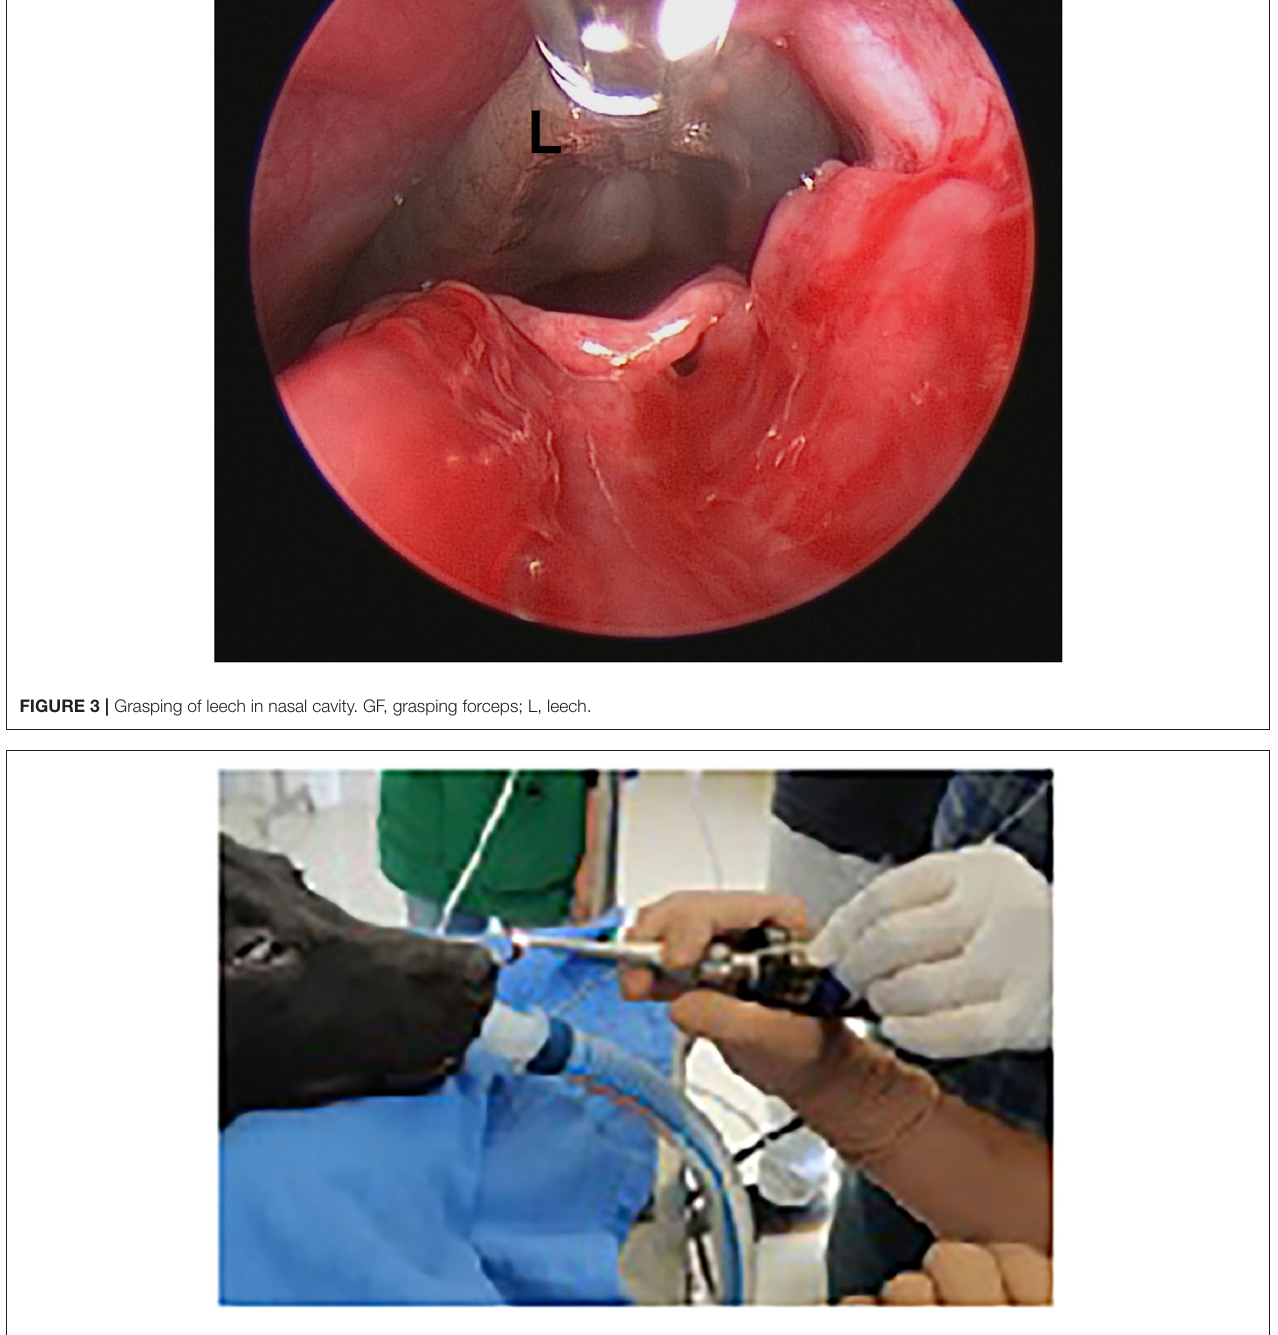
Frontiers in Veterinary Science |